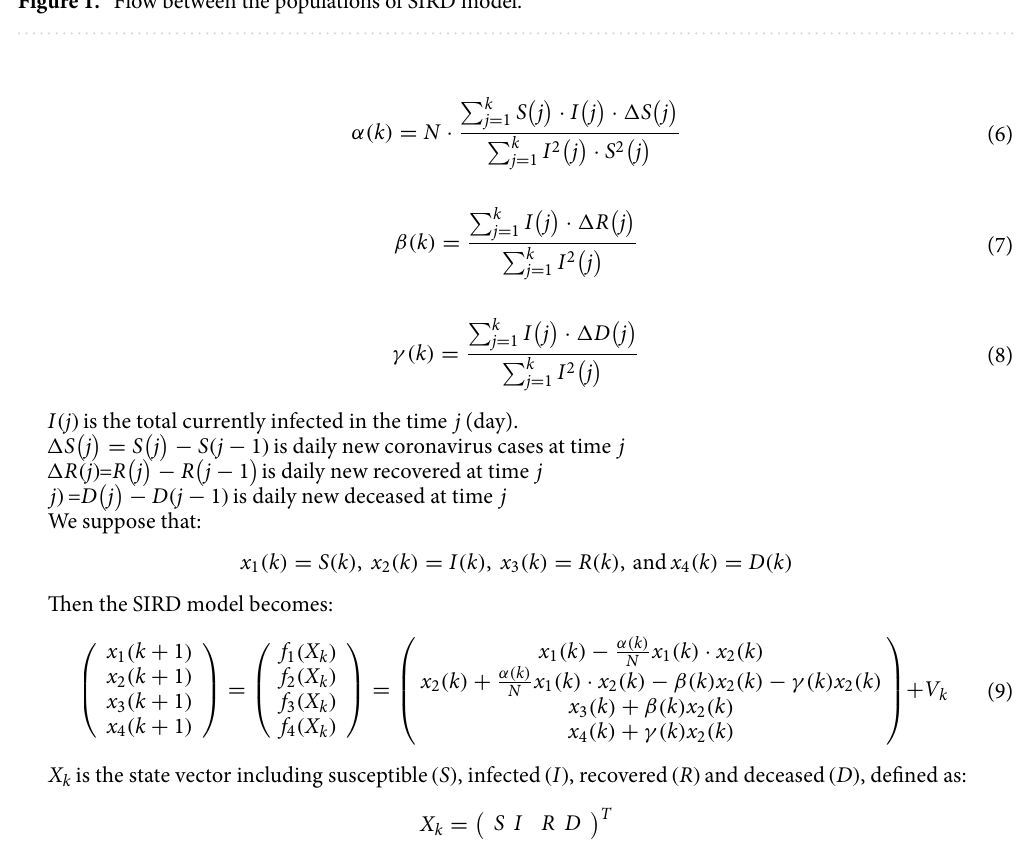
Figure 1. Flow between the populations of SIRD